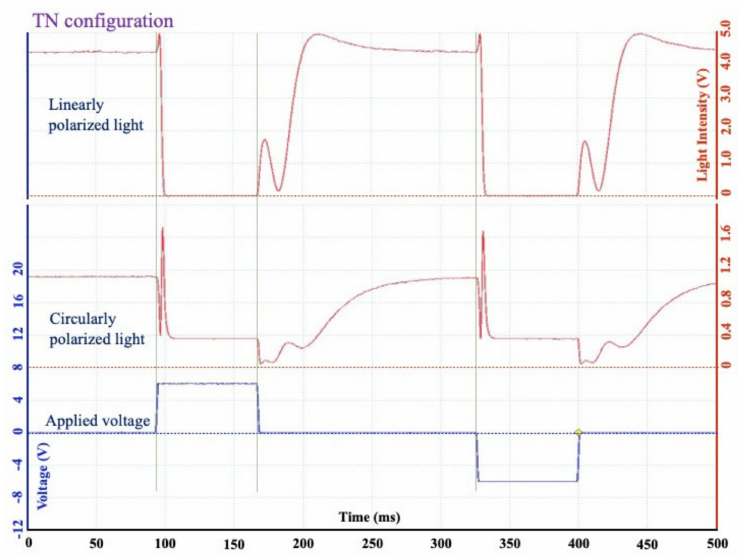
Figure 4. Light-throughput dynamics of a Twisted Nematic-Liquid Crystal (TN-LC) panel both to linearly polarized and circularly polarized incident light,